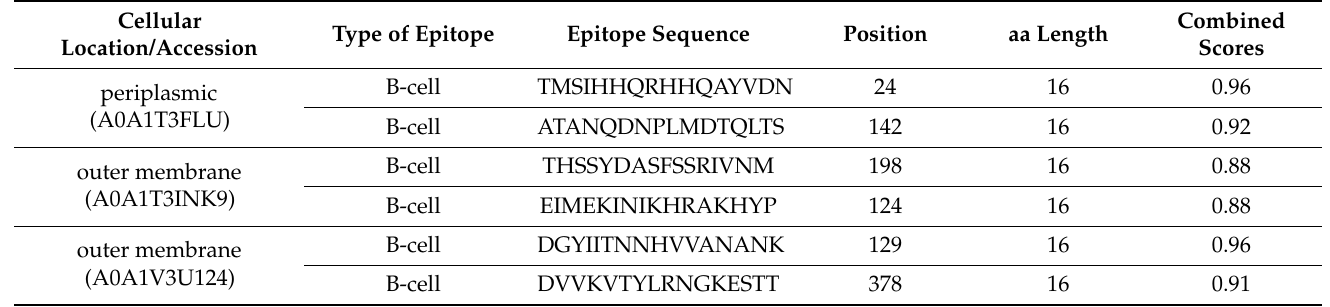
Table 4. The B-cell epitopes predicted for each of the selected proteins of E. meningoseptica including sequence information, position, and other